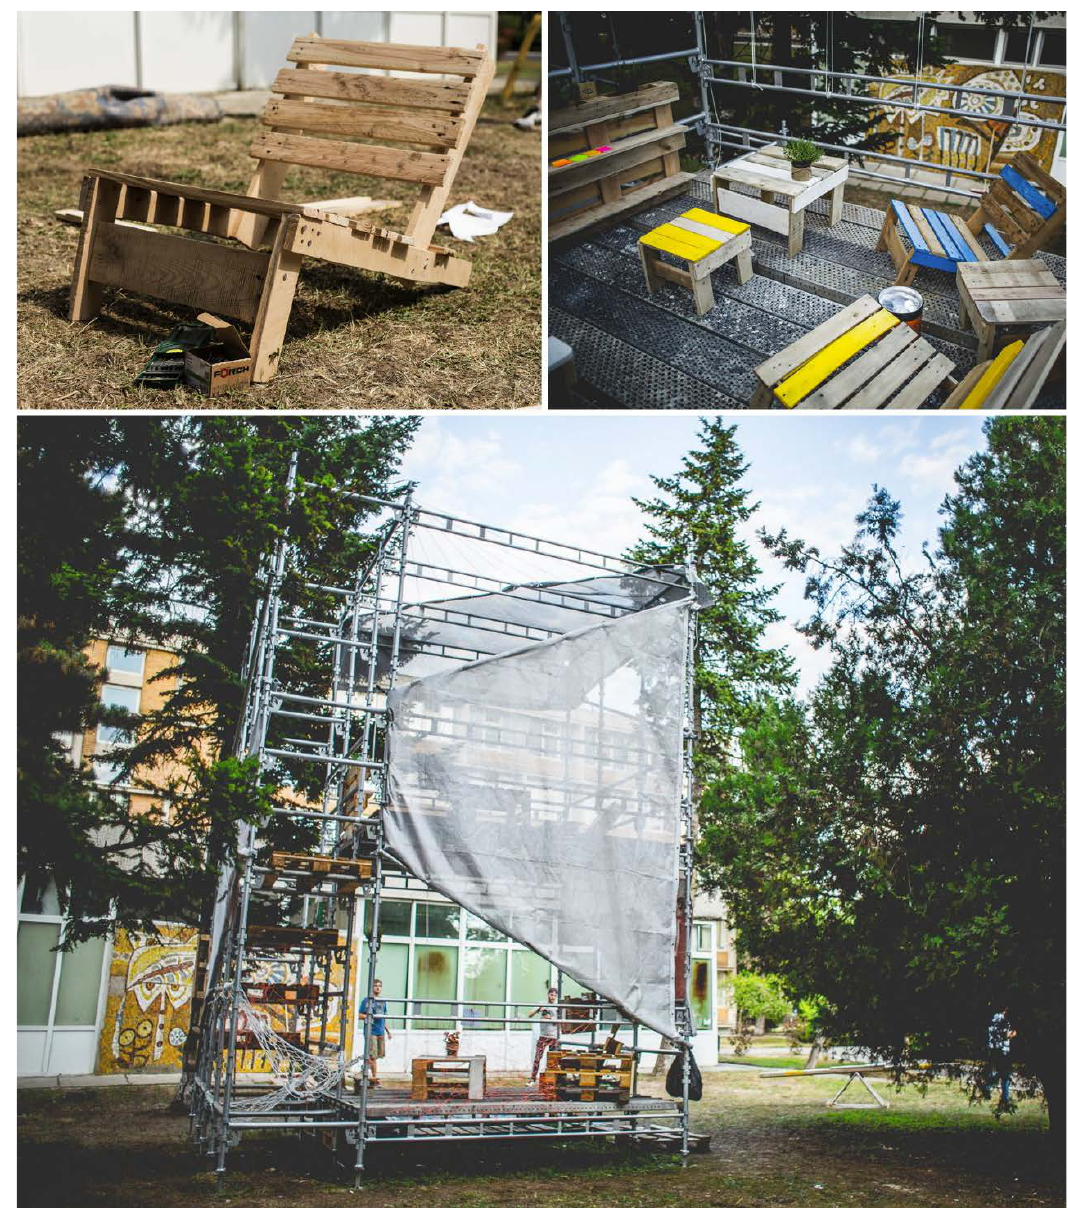
Figure 13: The “garage” and its